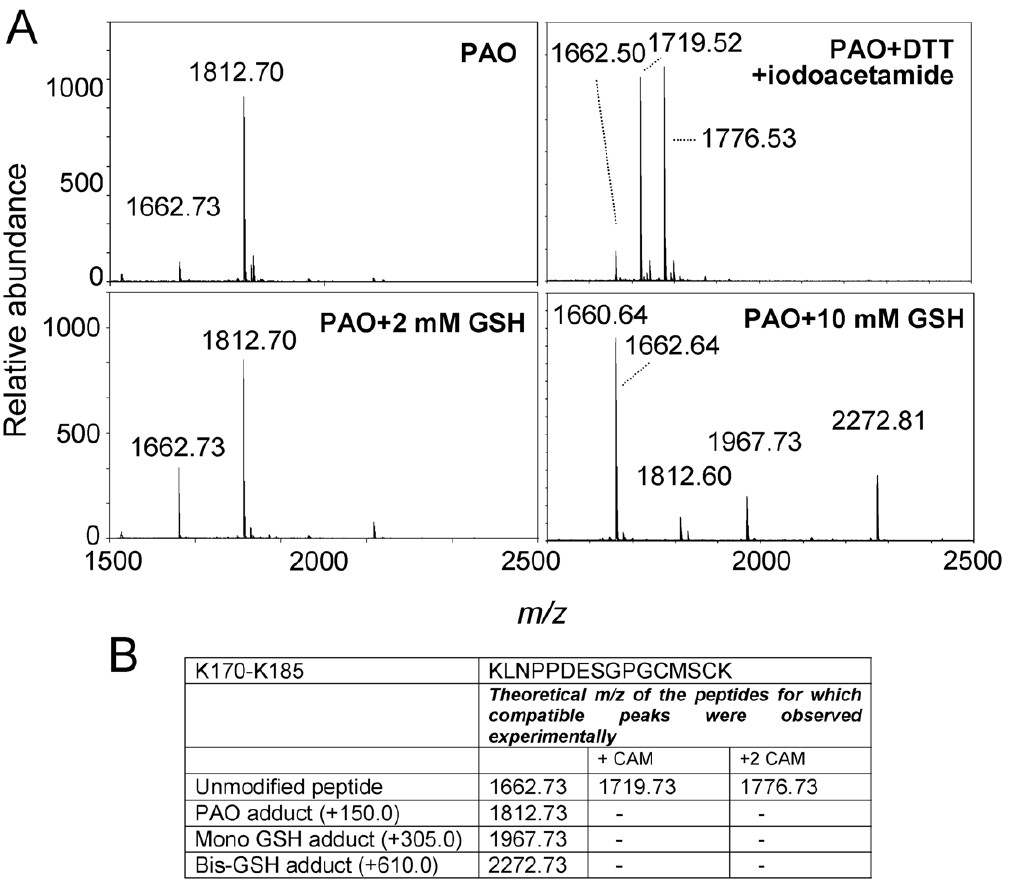
Figure 3. Effect of reducing agents on PAO modification of the K170-K185 peptide. (A) In the upper panels, the K170-K185 peptide was incubated with PAO and analyzed by MALDI-TOF MS. In the right panel, the incubation mixture was treated with 10 mM DTT and subsequently with 50 mM iodoacetamide. In the lower panels, the K170-K185 peptide was incubated with PAO in the presence of the indicated concentrations of GSH before analysis by MALDI-TOF MS. (B) Summary of the theoretical m/z of peptides for which compatible peaks were observed experimentally in the assays shown in (A).